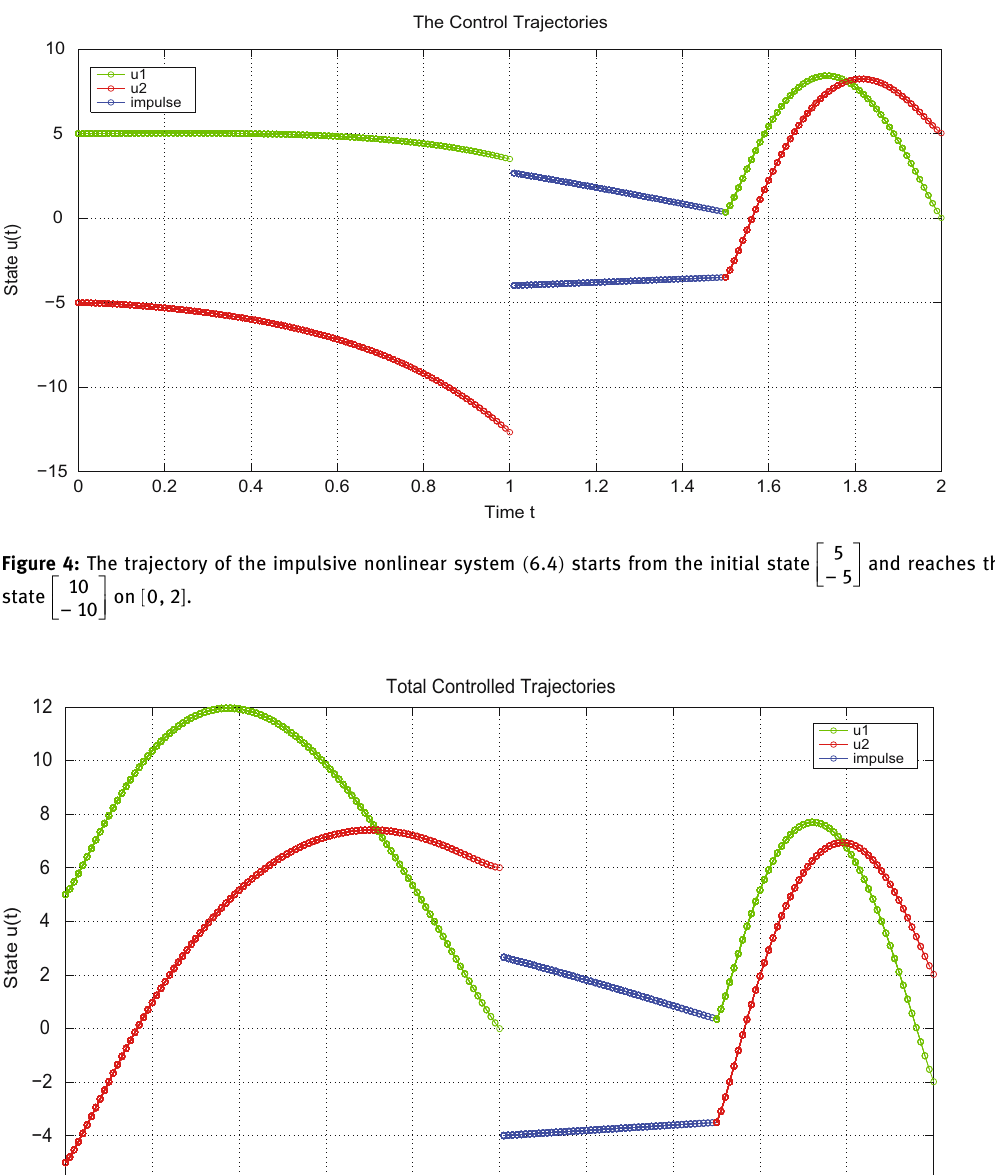
5   and reaches the fi nal states   − 5